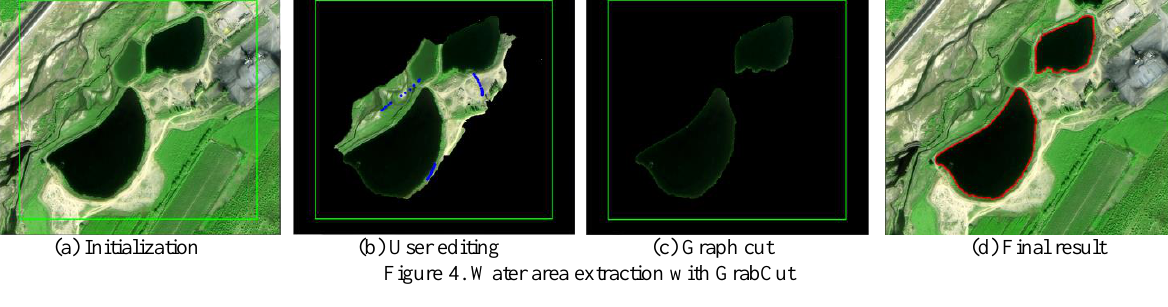
Figure 4. Water area extraction with GrabCut